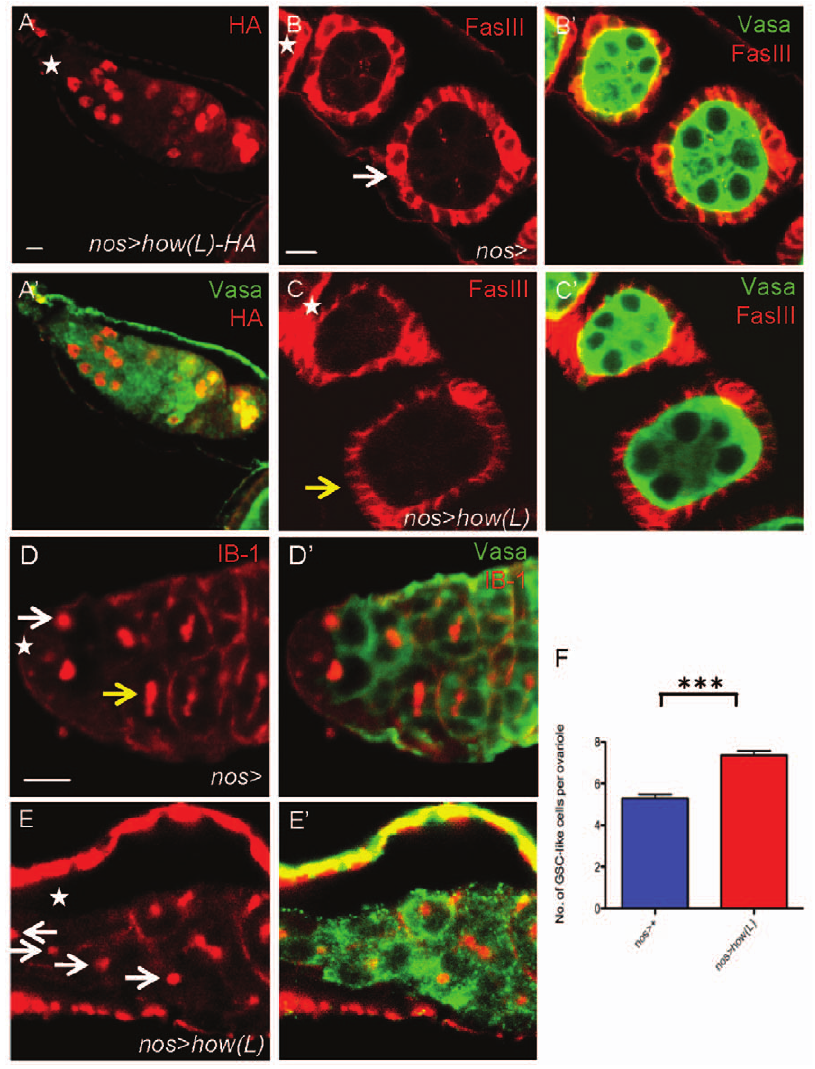
Figure 4. Overexpression of HOW(L) in the female germline results in extra GsC-like cells. ( A ) The UAS:HOW(L) construct contains an HA- tag. Anti-HA staining (red) on nos . how(L) germaria shows that expression of this transgene is beyond the normal HOW expression domain. ( B,C ) Ectopic HOW(L) does not result in extra rounds of germ cell mitoses . ( B ) In control ovaries ( nos . w 1118 ) a cystoblast will undergo four rounds of mitosis to generate 16 interconnected cystocytes. These develop into egg chambers containing one oocyte and 15 nurse cells (green), surrounded by follicle cells (red). ( C ) Overexpression of HOW(L) in the female germline results in egg chambers which contain exactly 16 cells (an oocyte and 15 nurse cells). ( D – F ) Overexpression of HOW(L) results in germaria containing more GSC-like cells ( E,E ’) than in control germaria ( D,D ’) , as observed by germ cells (green) displaying a round spectrosome (red, white q ), not a branched fusome (yellow q ). Anterior direction marked (*). Scale bar 5 m m.